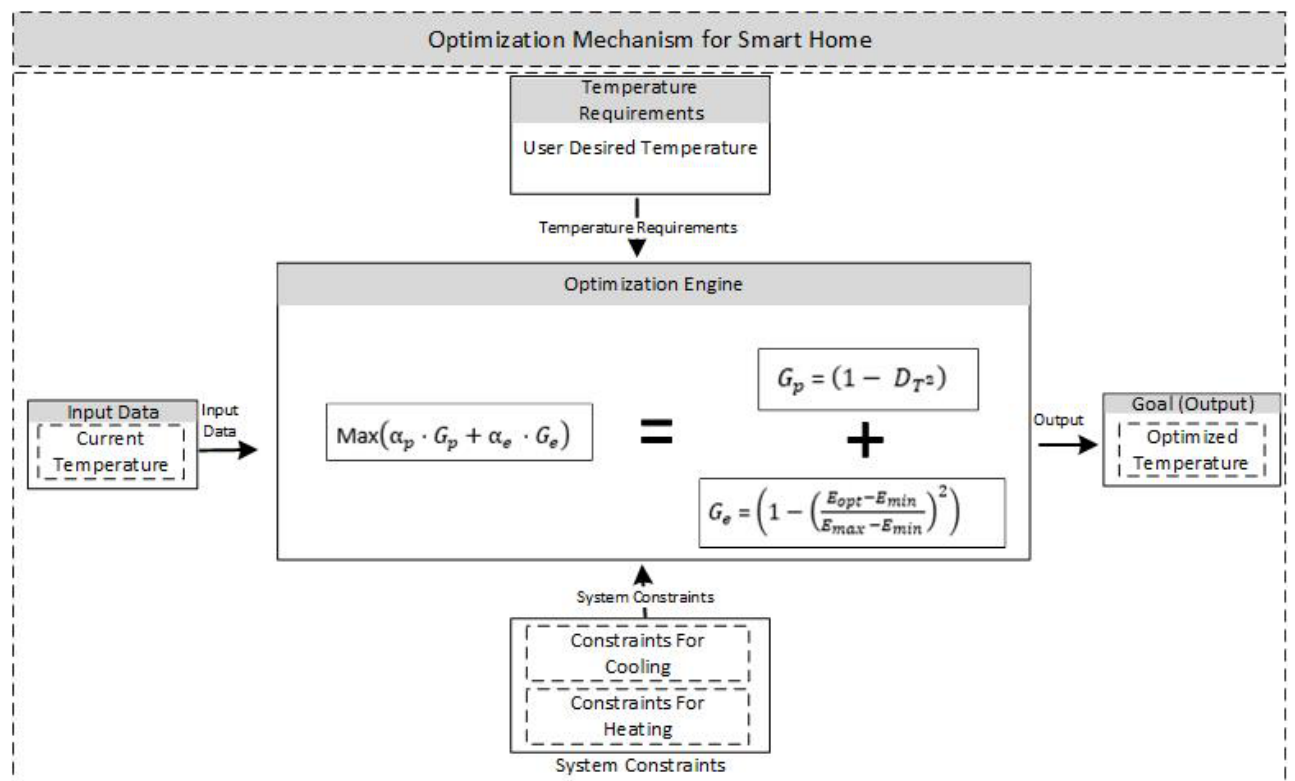
Figure 7. Objective Function Model of the Intelligent Optimization